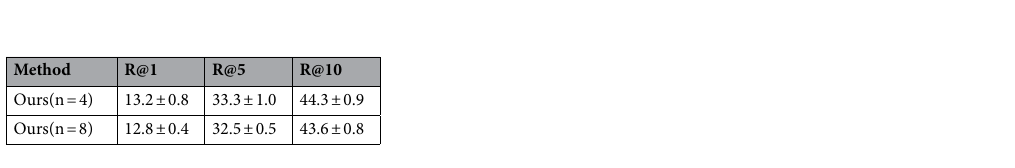
Table 6. Ablation studies of Transformer layers on MIT-States dataset.